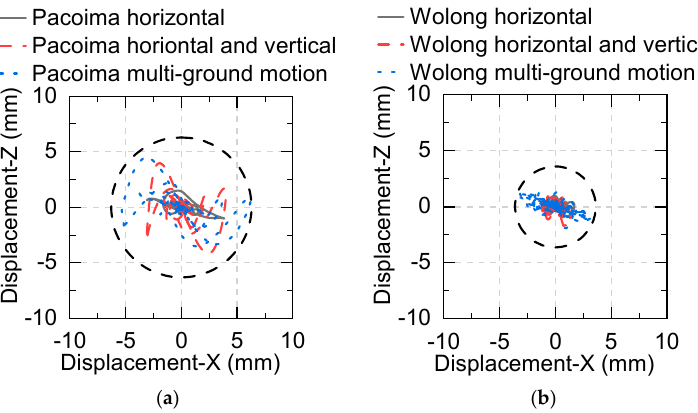
Figure 16. Displacements of point 1 in XZ plane with different input directions: ( a ) No. 22, 23, 24 test conditions; ( b ) No. 19, 20, 21 test conditions. Appl. Sci. 2020 , 10 , x FOR PEER REVIEW